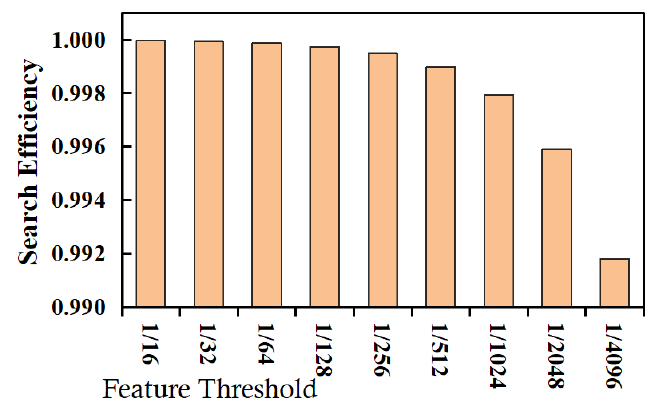
Figure 5. Evaluation results for textual data range query efficiency.